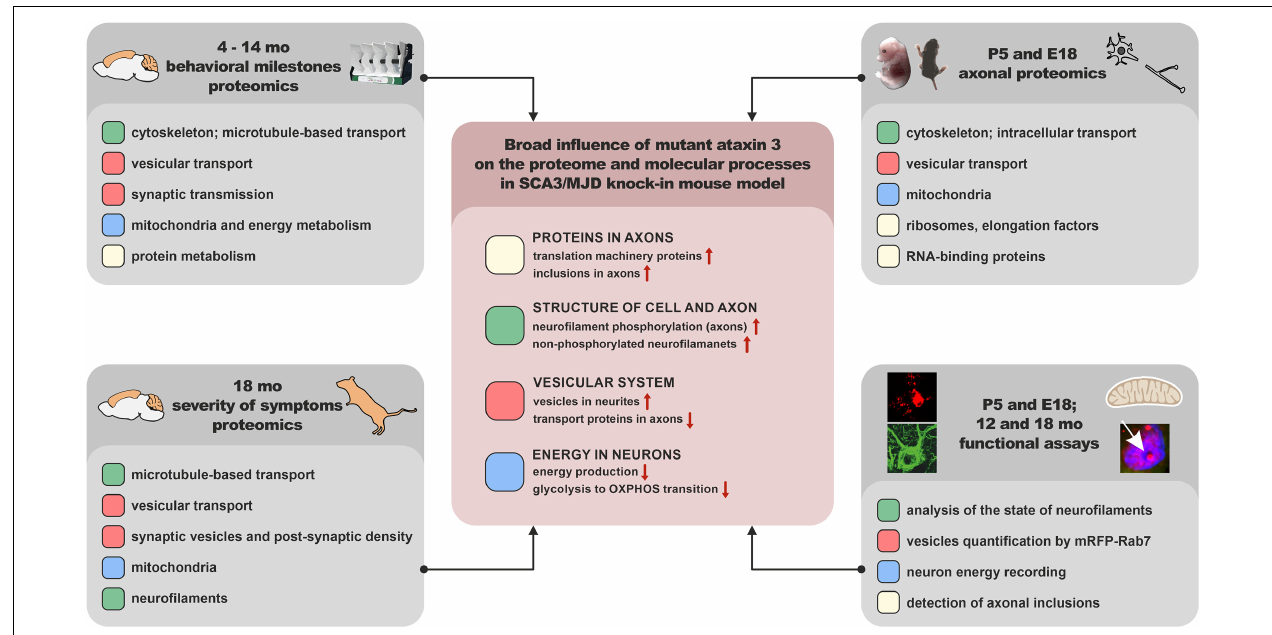
FIGURE 10 | The graphical summary of broad influence of mutant ataxin 3 on the proteome and molecular processes in SCA3/MJD knock-in mouse